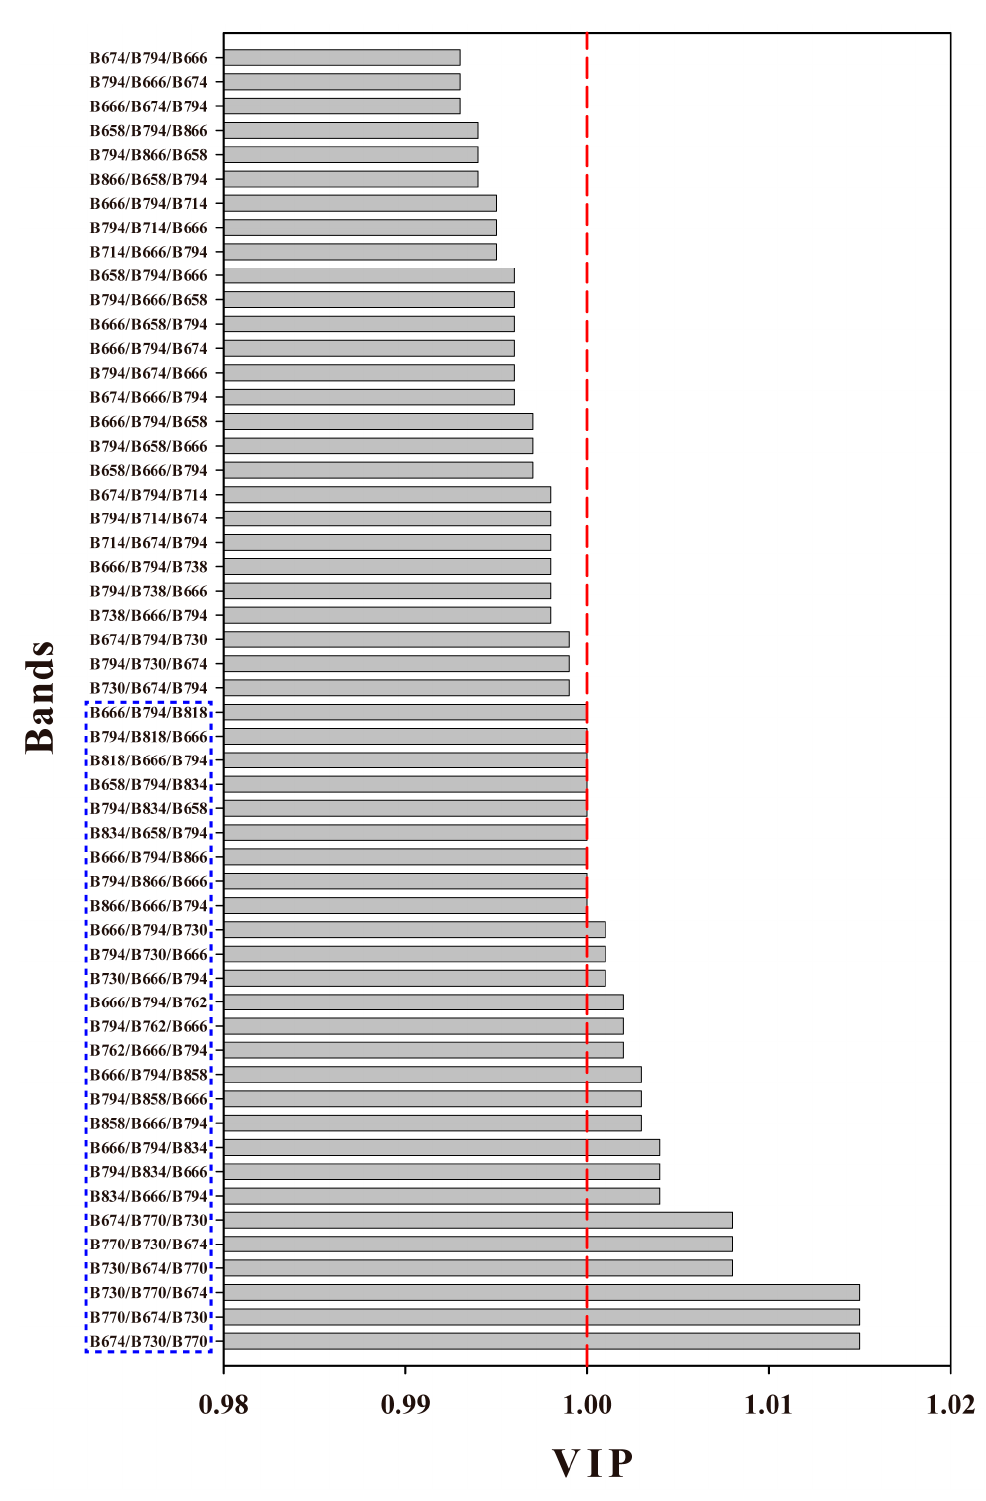
Figure 17. VIP screening diagram of model independent variables.